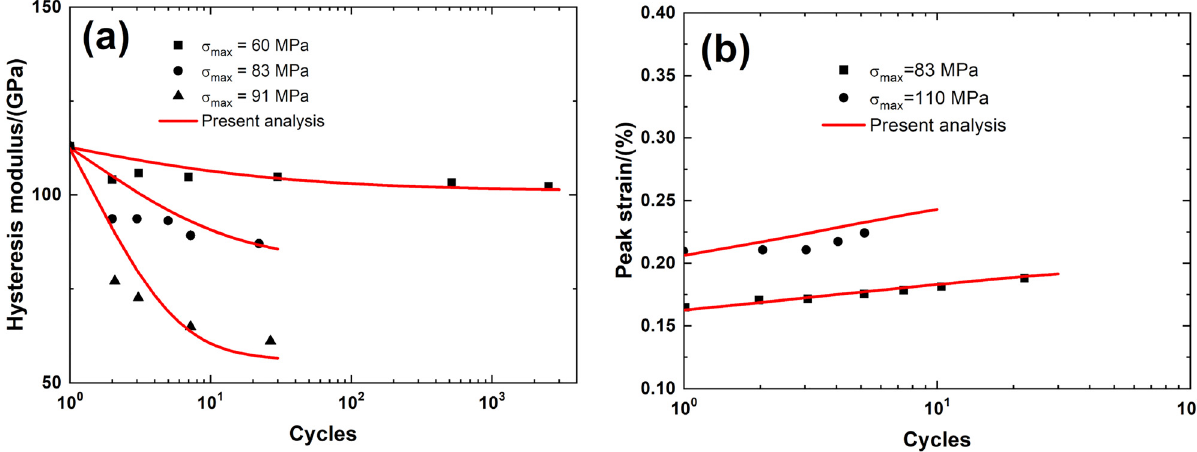
Figure 6: ( a ) The FHM versus applied cycle curves, and ( b ) the FPS versus applied cycle curves of cross - ply SiC/MAS composite under OP - TMF loading.